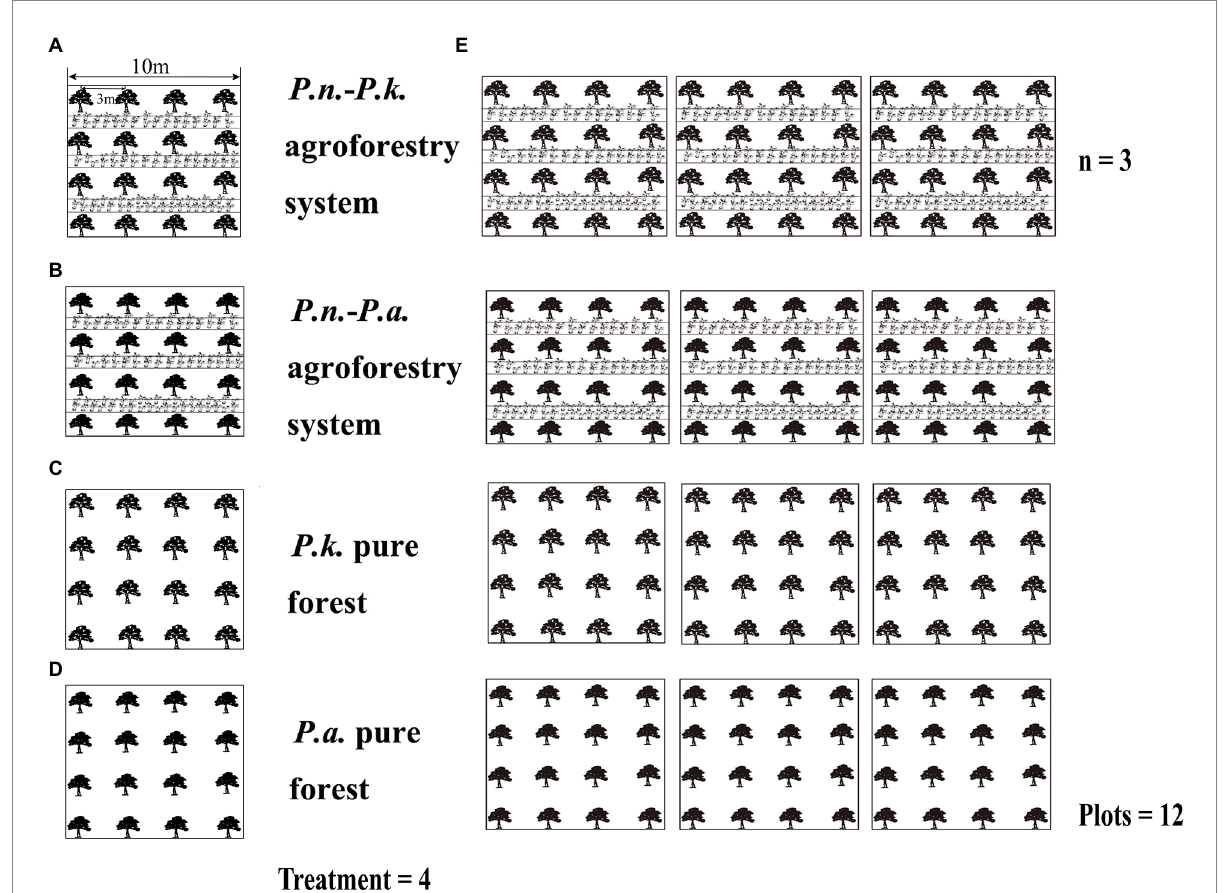
FIGURE 2 Four types of sampling plots and sampling plot design. [sample plots of P.n. - P.k. agroforestry system (A) , P.n. - P.a. agroforestry system (C) , and two types of pine pure forest (B,D) and sample plots design (E)